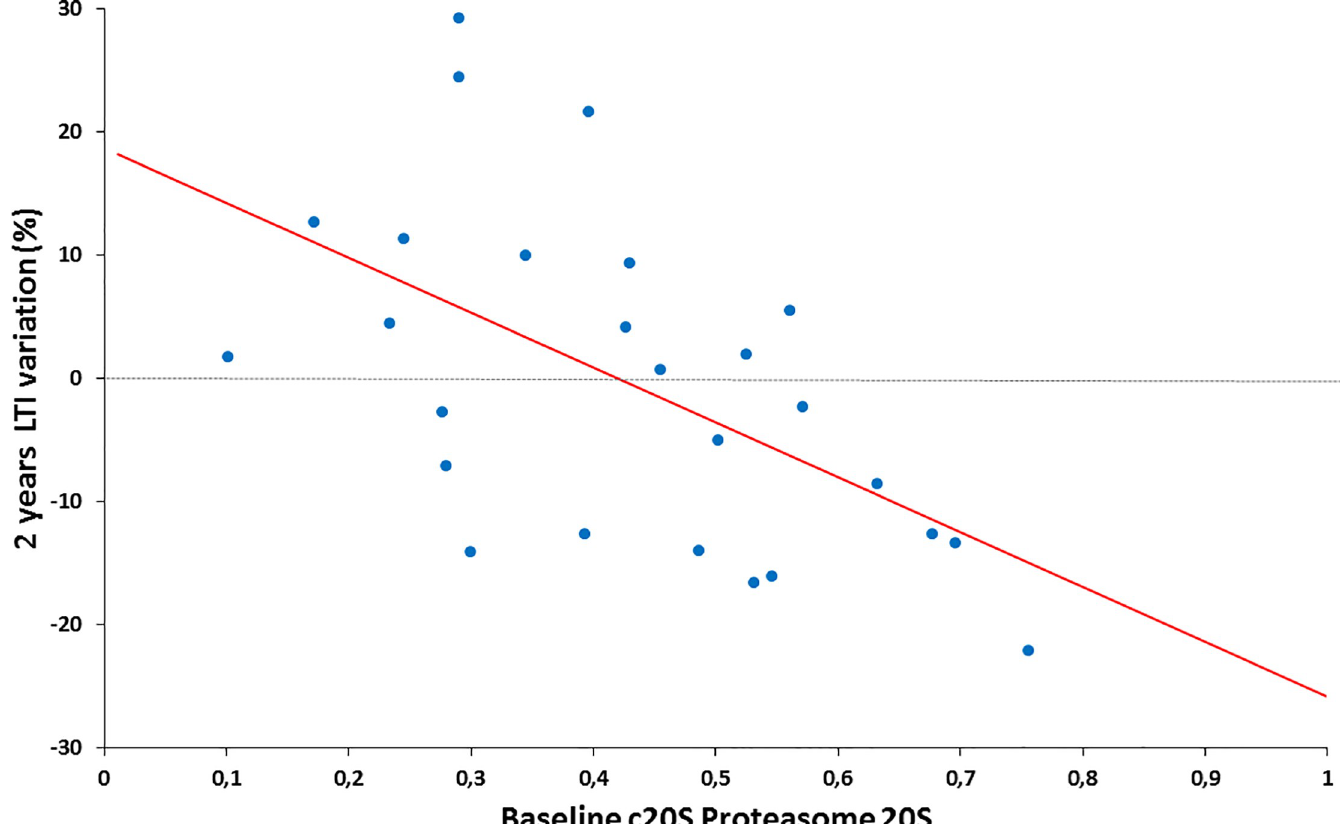
Fig 2. Linear regression between two years LTI variation and baseline c20S proteasome. c20S proteasome, circulating 20S proteasome; LTI, lean tissue index measured by multifrequence bioimpedancemetry.